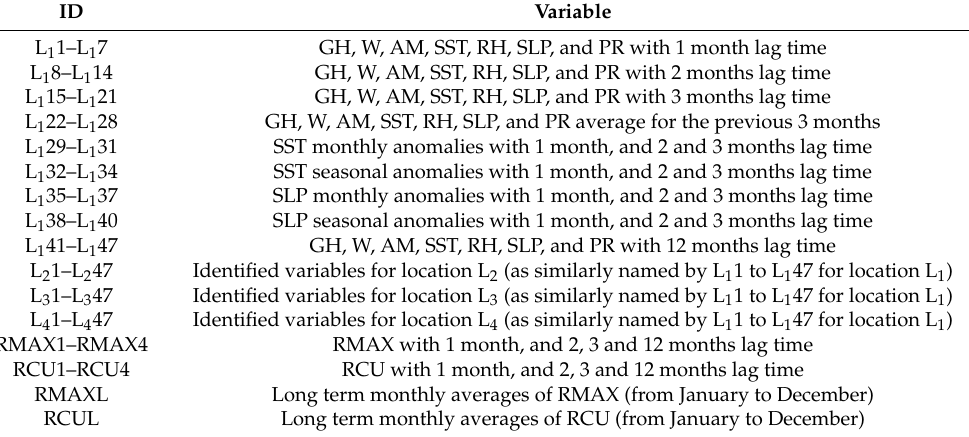
Table 3. List of the large scale climate and precipitation variables considered to develop the rainfall forecasting